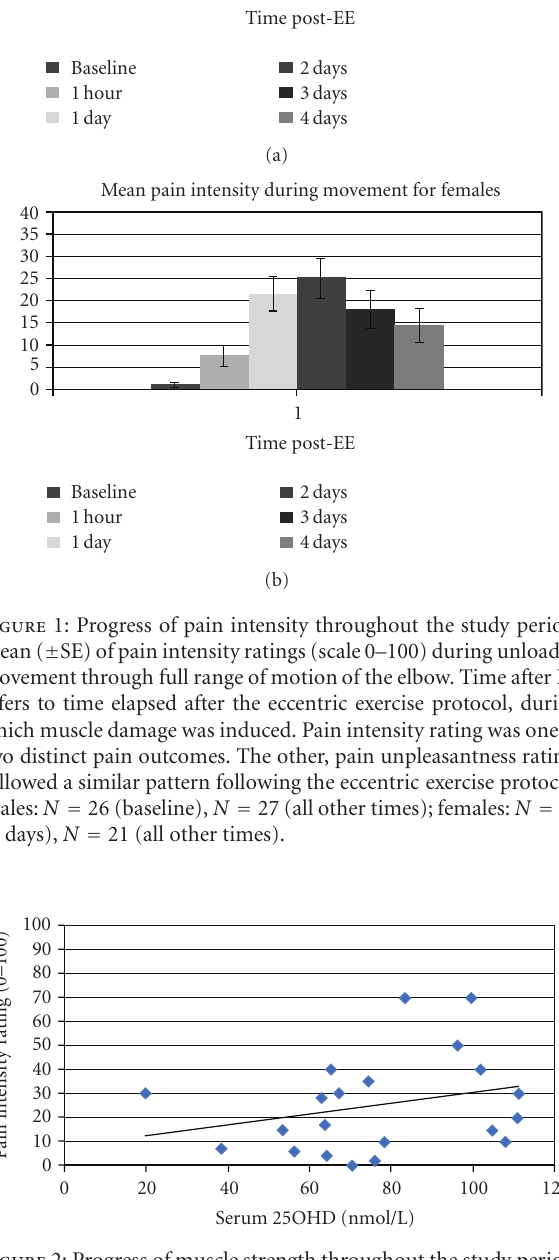
Figure 2: Progress of muscle strength throughout the study period. Mean ( ± SE) peak torque for males and females during isometric strength testing of the elbow flexors. Time after EE refers to time elapsed after the eccentric exercise protocol, during which muscle damage was induced. N m = Newton-meters. Males: N = 25 (4 days), N = 26 (baseline, 1 hour, 2 and 3 days), N = 27 (1 day); females: N = 20 (4 days), N = 21 (all other